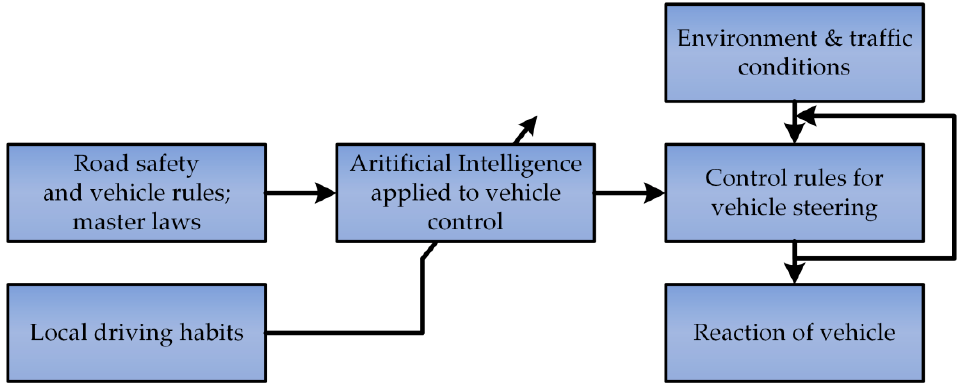
Figure 1. The concept of the data processing based on artificial intelligence in the autonomous ve- hicle.